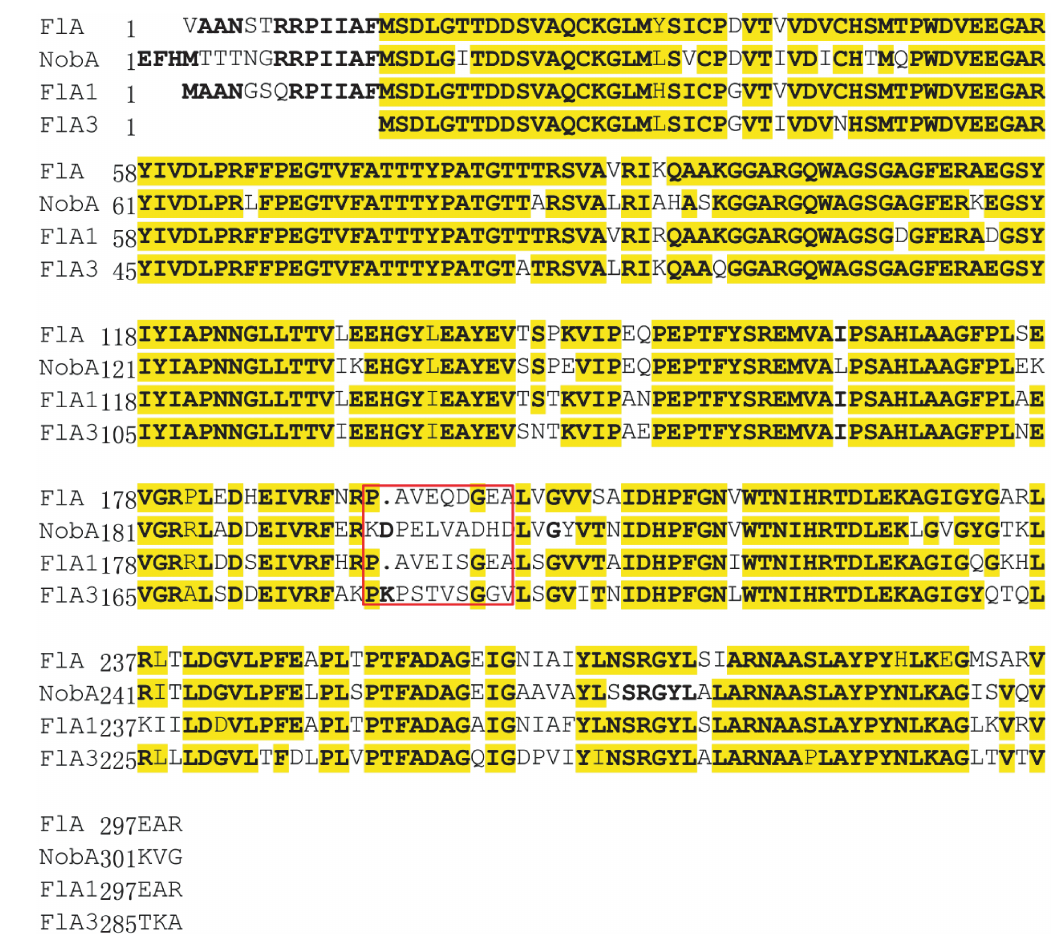
Figure S3. Sequence comparison between FlA, NobA, FlA1 and FlA3. Conserved residues are indicated by bright yellow. The distinct loop region (R192-L202, FlA numbering) is highlighted by rectangle. FlA and NobA are from this study; FlA1 is from Streptomyces sp. MA-37 and FlA3 is from Actinoplanes sp . N902-109 39